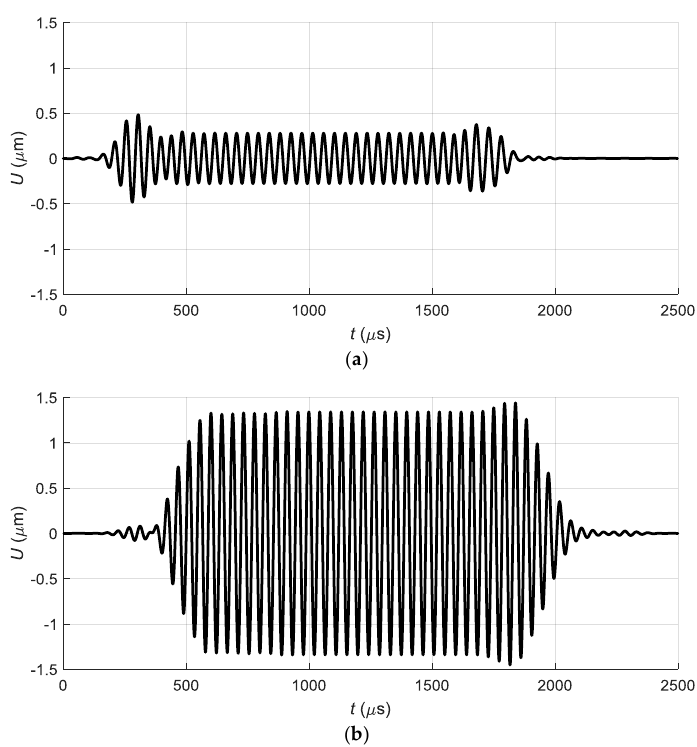
Figure 12. Waveforms of the A 0 mode normal displacements U in PVC film at the point P ND excited by the linear air-coupled array: ( a )—simultaneous excitation of all array elements, ( b )—in-phase excitation of the array elements with delays.